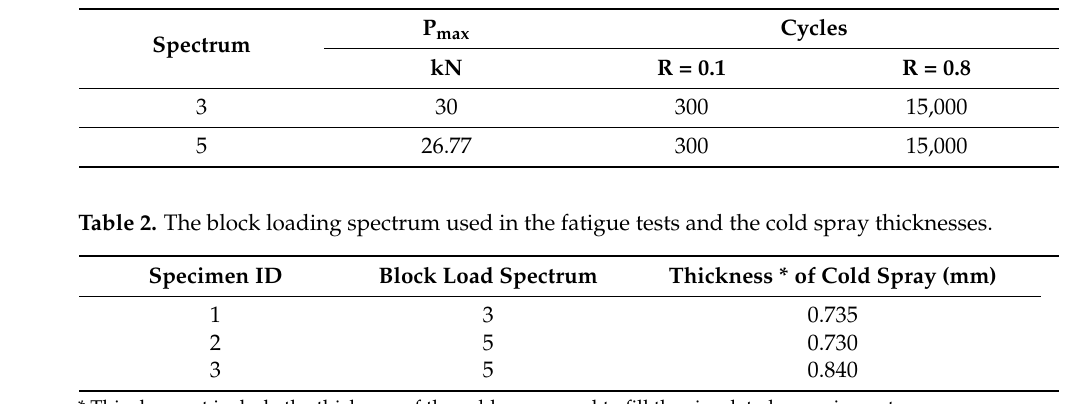
Figure 1. Dimensions of the “dog bone” specimen geometry. Table 1. Block loading spectrum.